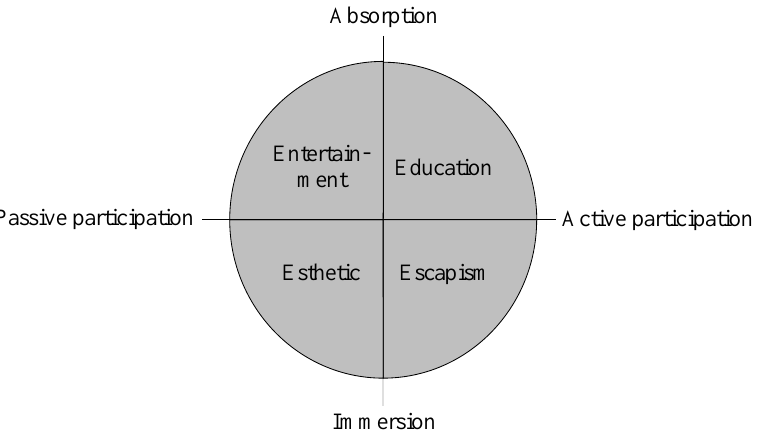
Figure 1. Four dimensions of Pine and Gilmore. Source: own graphic based on Pine and Gilmore (1999).